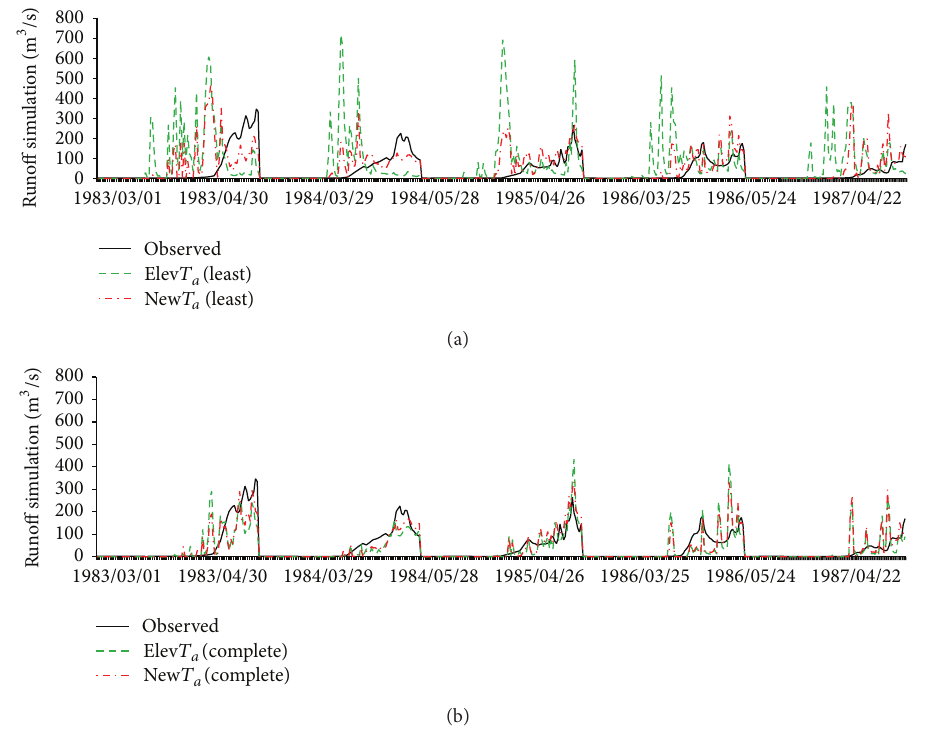
Figure 9: Spring snowmelt simulation (March, April, and May) results of the least parameters setting (a) and complete parameters setting (b) of basin